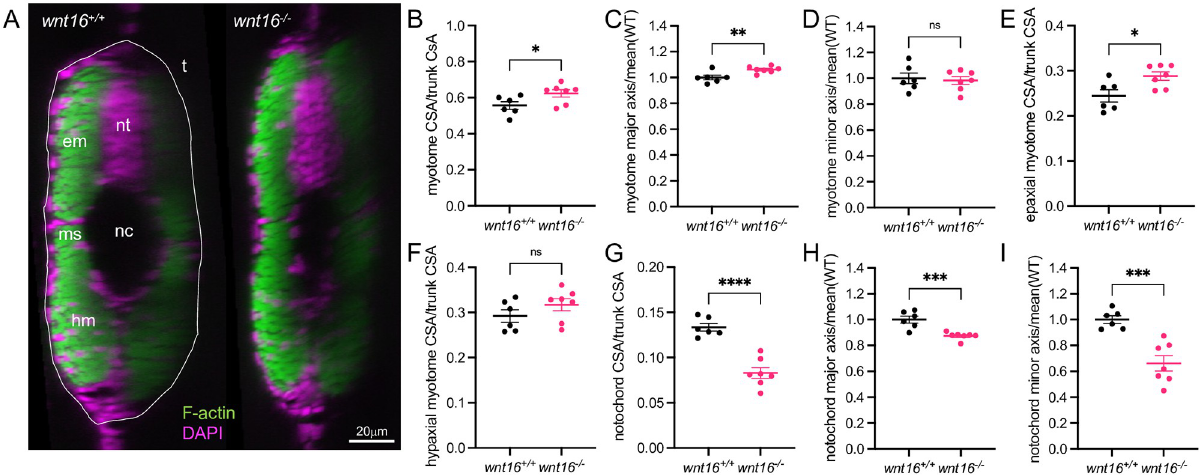
Fig 4. wnt16 suppresses myotome expansion and promotes notochord radial expansion. (A) Transverse views of phalloidin-stained 3dpf animals. em: epaxial myotome, hm: hypaxial myotome, ms: myosepta, nc: notochord, nt: neural tube, t: trunk. (B-I) Quantification of myotome (B-F) and notochord (G-I) morphology. P-values were determined using an unpaired t-test. � p < 0.05, �� p < 0.01, ��� p < 0.001, ���� p < 0.0001, ns: not significant.